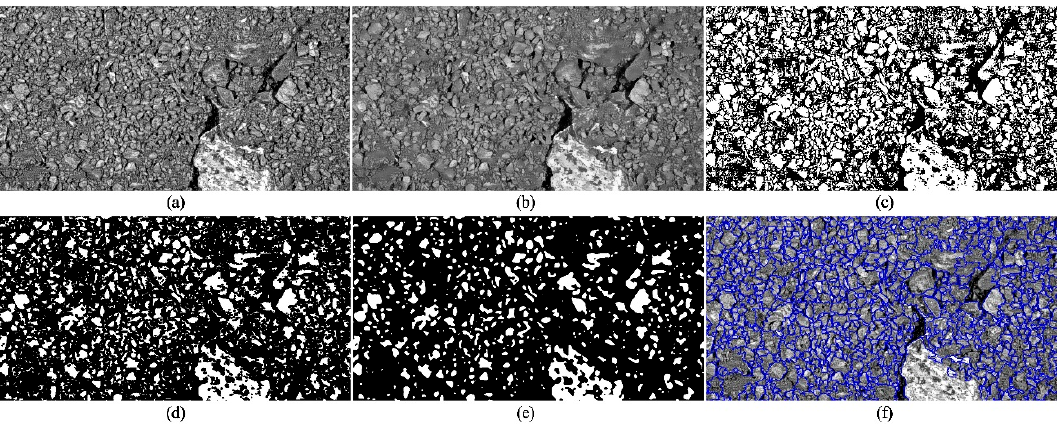
Figure 8. Original ( a ), after the first step ( b ), after the second step ( c ), after the erosion operation ( d ), after the third step ( e ), and after the fourth step ( f ).